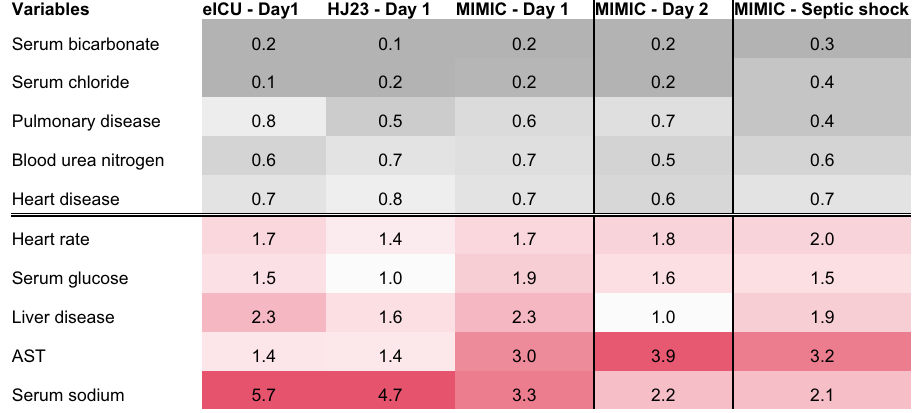
Table 3. Association of top 10 variables with serum lactate levels in the three datasets (day 1). Second to right column reflects sensitivity analysis for MIMIC-III on day 2. Right column reflects sensitivity analysis limiting analysis to patients with septic shock. An odds ratio (OR) > 1 (red) indicates that variables are associated with high lactate levels. Continuous variables are standardized, i.e., a 1 standard deviation increase is associated with an increase in the shown OR. AST Aspartate